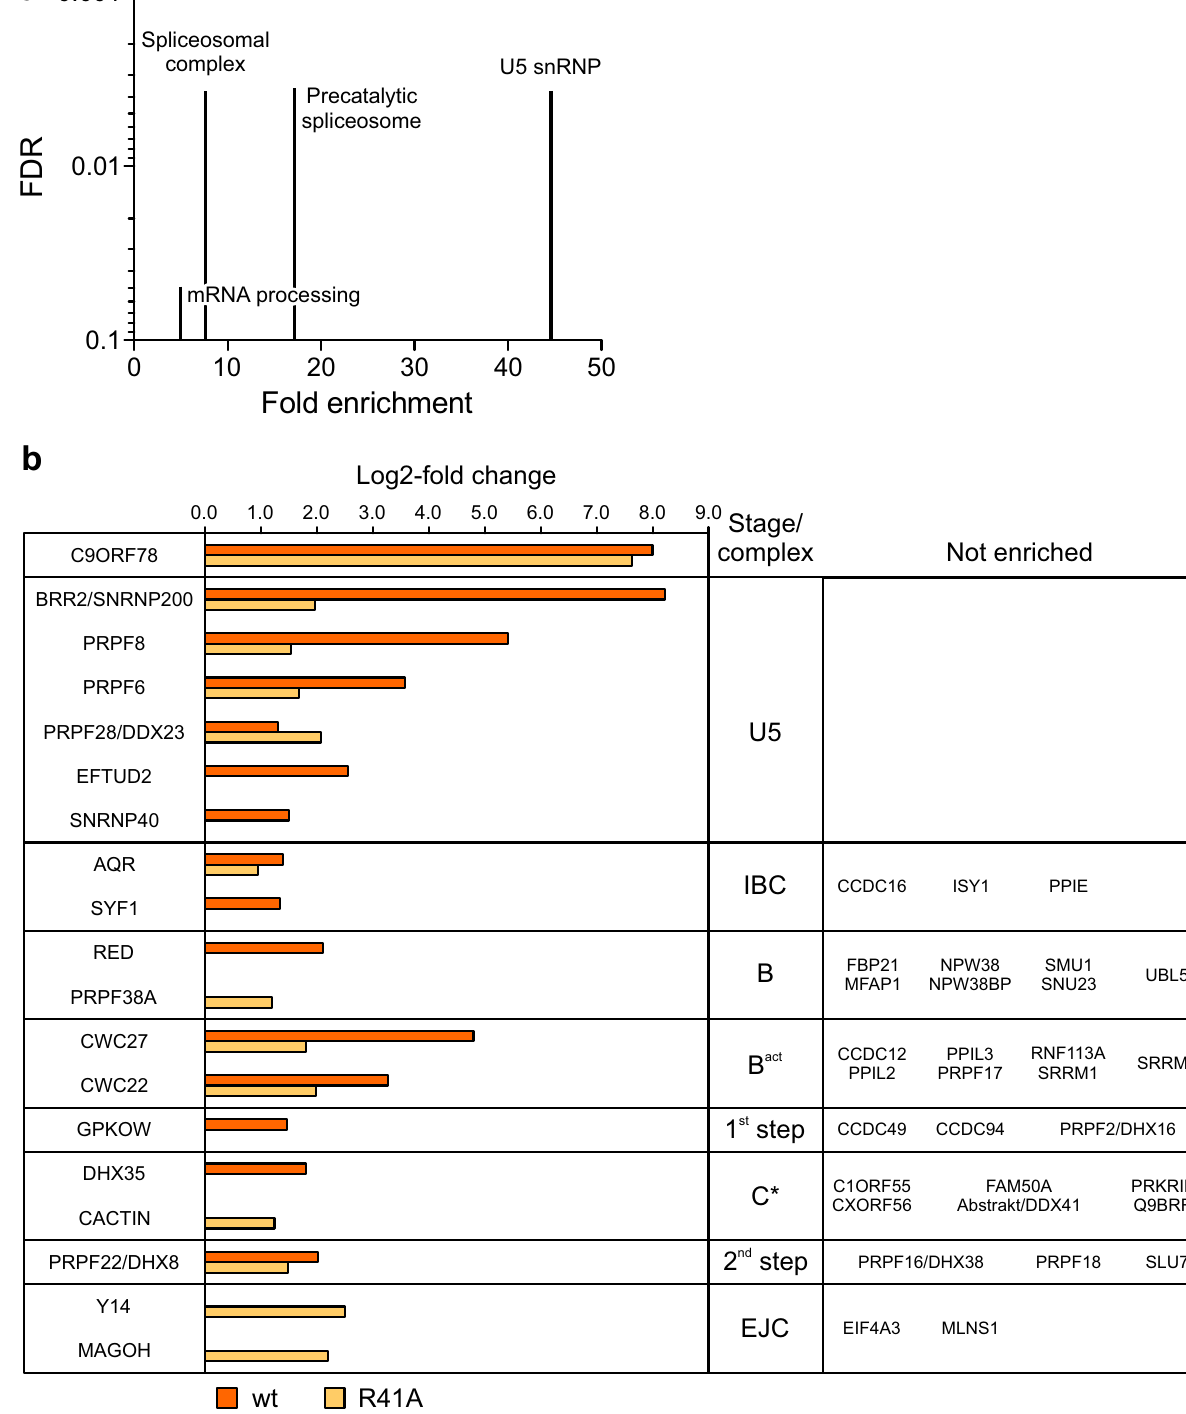
Fig. 7 Proteins enriched in Flag-C9ORF78 wt and Flag-C9ORF78 R41A IPs. a GO term analysis for proteins signi fi cantly enriched in C9ORF78 IPs (log2-fold change >3). Genes expressed in HEK293T cells were used as a background list. Fold enrichment is depicted on the x-axis, the false discovery rate (FDR) on the y-axis. b Spliceosomal proteins enriched in Flag-IP from nuclear extract of Flp-In ™ T-REx ™ 293 cells stably expressing Flag-C9ORF78 wt (orange) or Flag-C9ORF78 R41A (light orange). Proteins were assigned to complexes/stages according to 4 . Other co-precipitated proteins are listed in Supplementary Data 2. Data represent log2-fold protein intensity differences of Flag-C9ORF78 IP (wt or R41A) vs. control Flag-IP, n = 3 technical replicates. Source data are provided as a Source Data fi